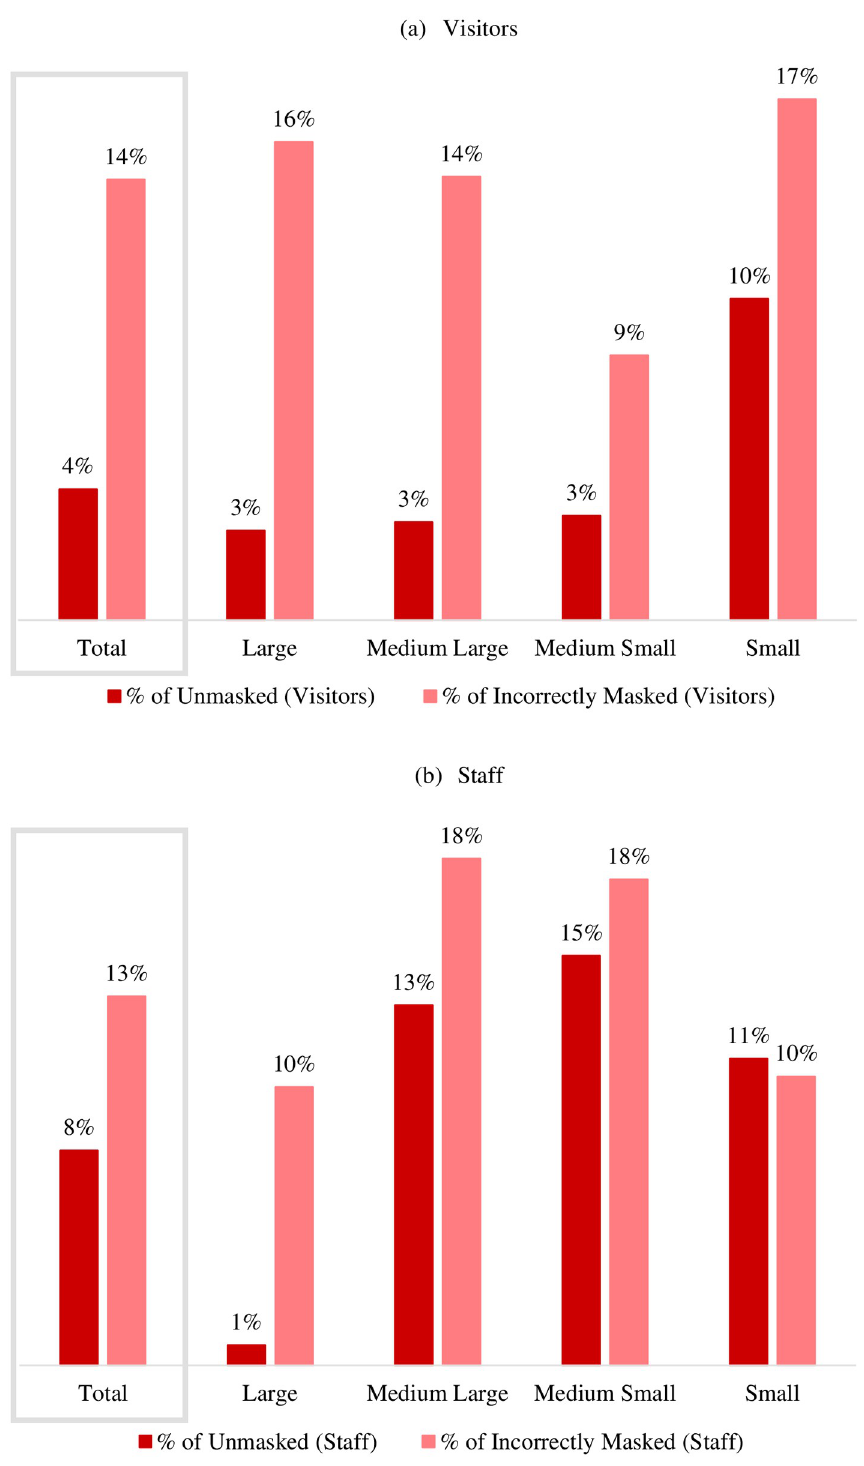
Fig 1. The average prevalence of the unmasked and improperly masked among visitors and staff of Louisville indoor public areas by public area size, Dec. 14–20, 2020. Large PAs are those with a square footage of at least 5000, between 2500 and 4999 sq ft for medium large, 1500 to 2499 sq ft for medium small, and 1499 or less for small.